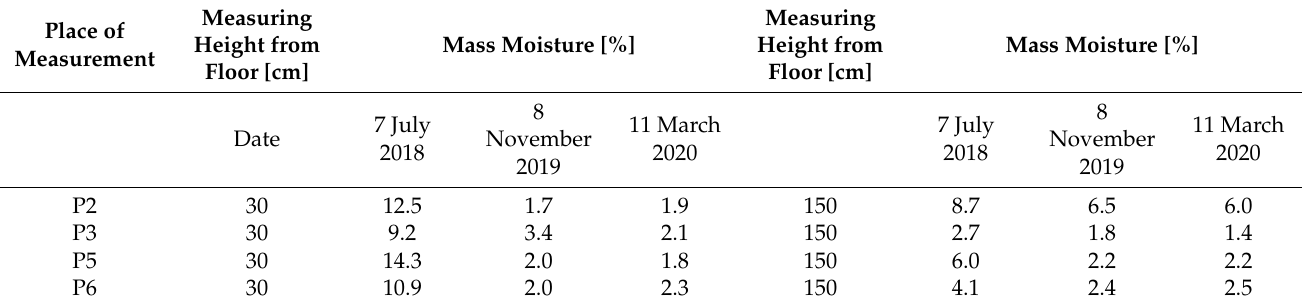
Table 2. Selected moisture values before and after the implementation of remediation technology no. 1. Place of